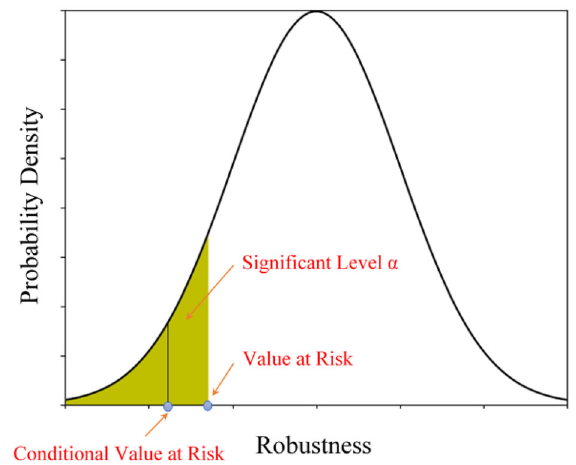
Fig. 1 Demonstration of the conditional value at risk (CVaR) concept in terms of